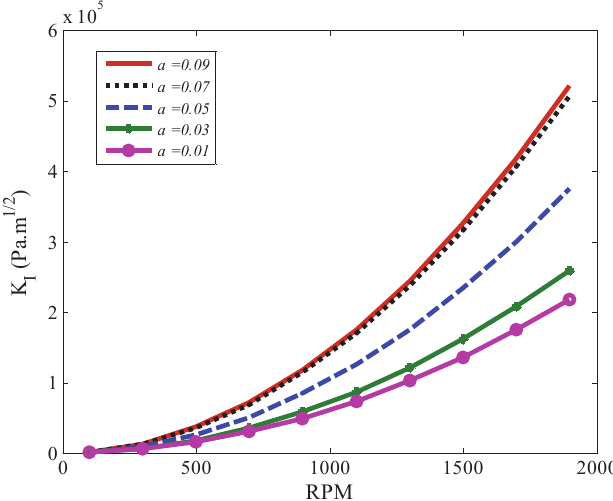
Figure 9: SIF vs. rotational speed of cylinder curves for different values of circumferential crack length. The longitudinal displacement and stress contours for an axisymmetric cross section of a hollow cylinder with